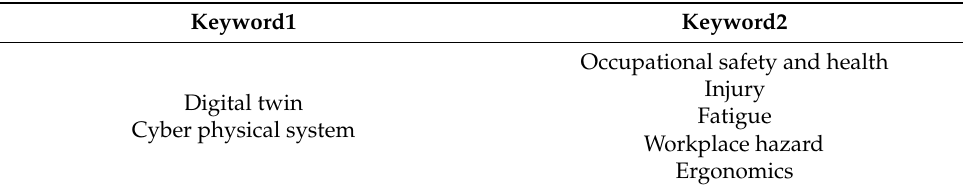
Figure 1. Overall survey procedure. Table 1. Keywords for the initial search.